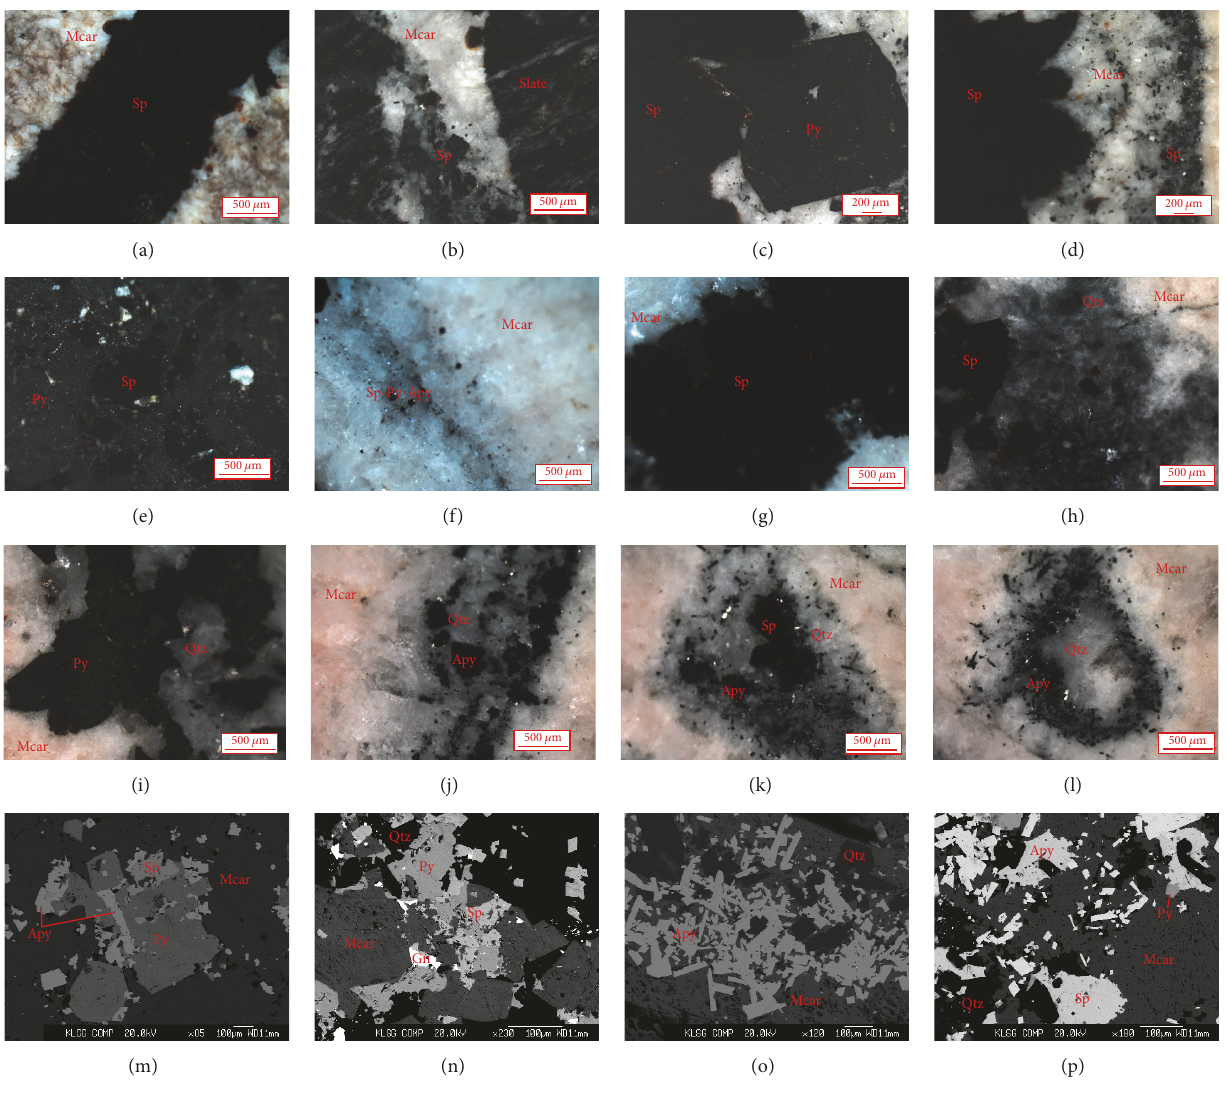
Figure 6: The photomicrographs and electron probe micrographs of sampling area in the annular polished section samples for EPMA and Fe-Zn isotopic analyses. (a) 9-3-2; (b) 9-8-8; (c) 9-8-2; (d) 9-8-3 and 9-8-5; (e) ZXK-1-4; (f) ZXK-1-3; (g) ZXK-1-2; (h) ZXK-2-1; (i) ZXK-2-5; (j) ZXK-2-2; (k) ZXK-2-3; (l) ZXK-2-4; (m) ZXK-1-3; (n) ZXK-2-5; (o) ZXK-2-2; (p) ZXK-2-3. Abbreviations are as in Figure